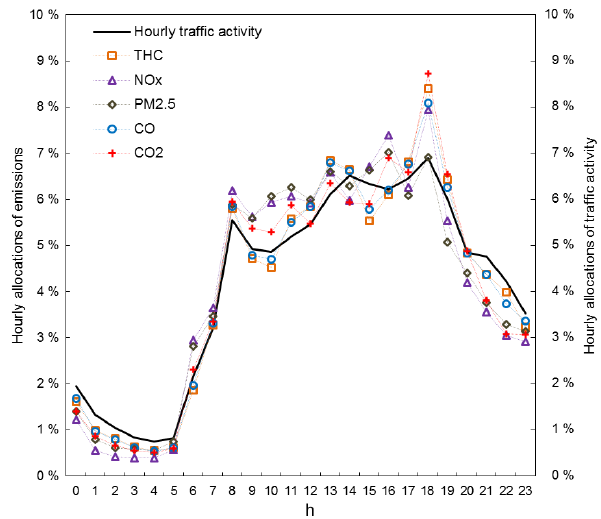
Figure 5. Hourly allocations of vehicular emissions and traffic ac- tivity in Macau during weekdays in